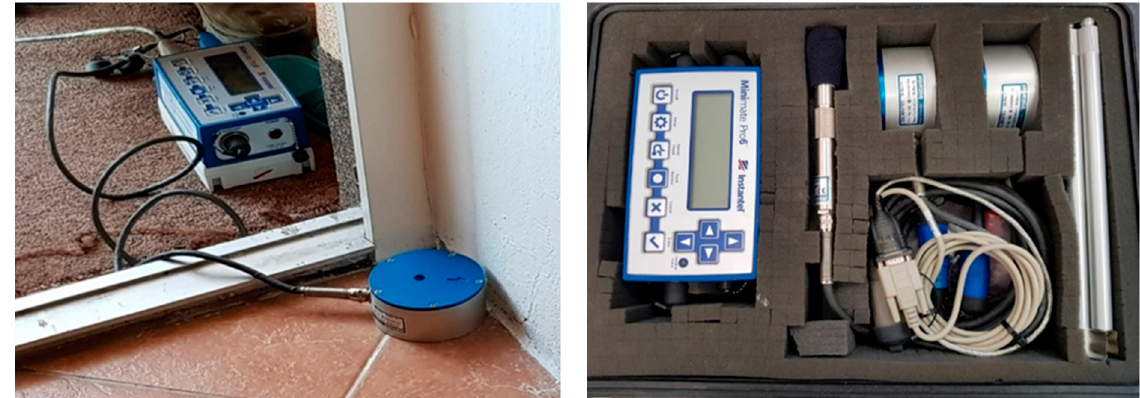
Figure 4. Placement of the vibrographs Minimate Pro 6-Position S1 (source: author).